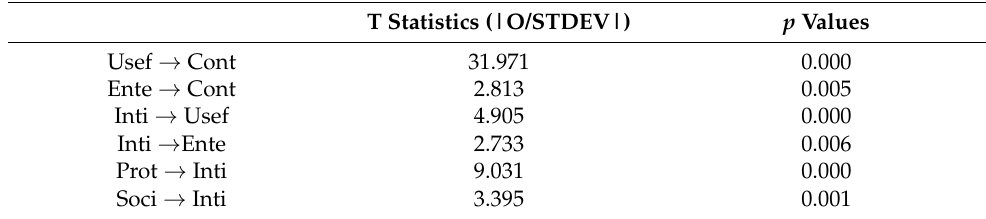
Figure 3. PLS-SEM analysis results. (** p < 0.01, *** p < 0.001.) Table 6. Path